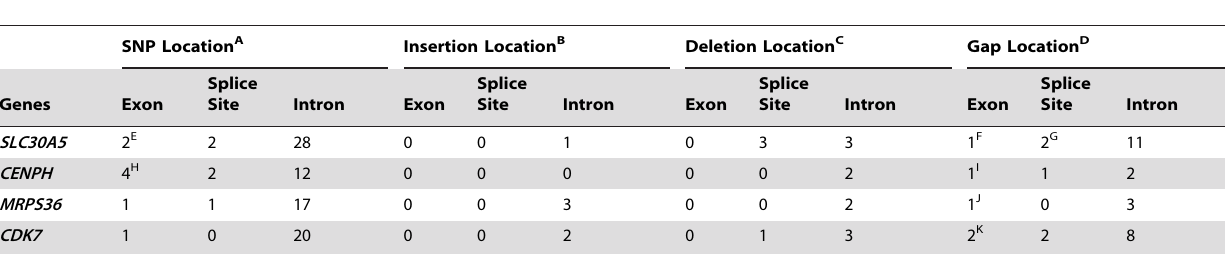
Table 6. Location of unique SNPs, micro-indels, and gaps identified by CA/NGS technologies within the candidate genes residing in the 176 kb